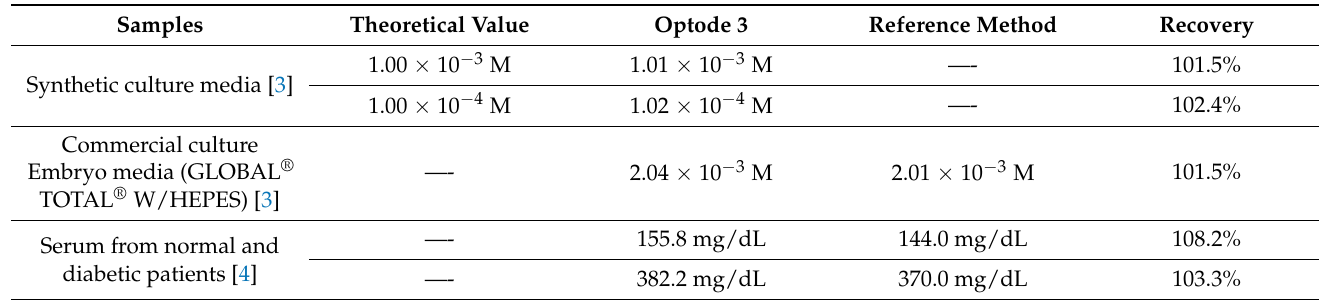
Table 3. Determination of glucose in different glucose-rich culture media .